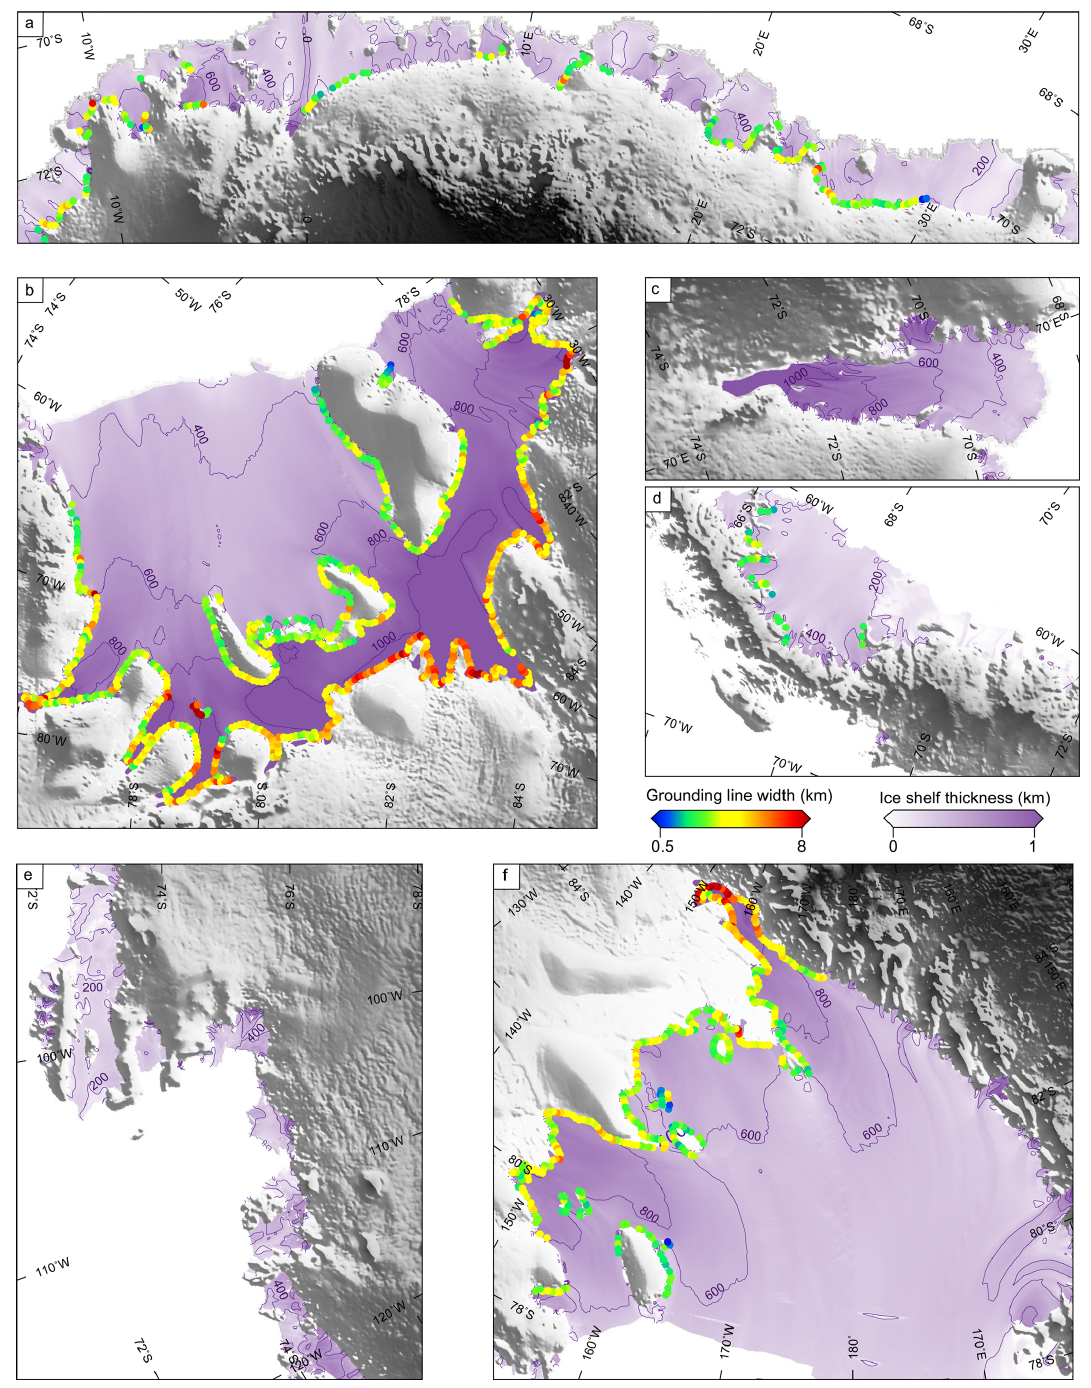
Figure 6. Grounding line width ( W ) for (a ) Dronning Maud Land, (b) Filchner–Ronne Ice Shelf, (c) Amery Ice Shelf and (d) Antarctic Peninsula. (e) Amundsen Sea sector and (f) Ross Ice Shelf. The background image is the ice shelf thickness (Chuter and Bamber, 2015) overlain on the Bedmap-2 DEM (Fretwell et al.,